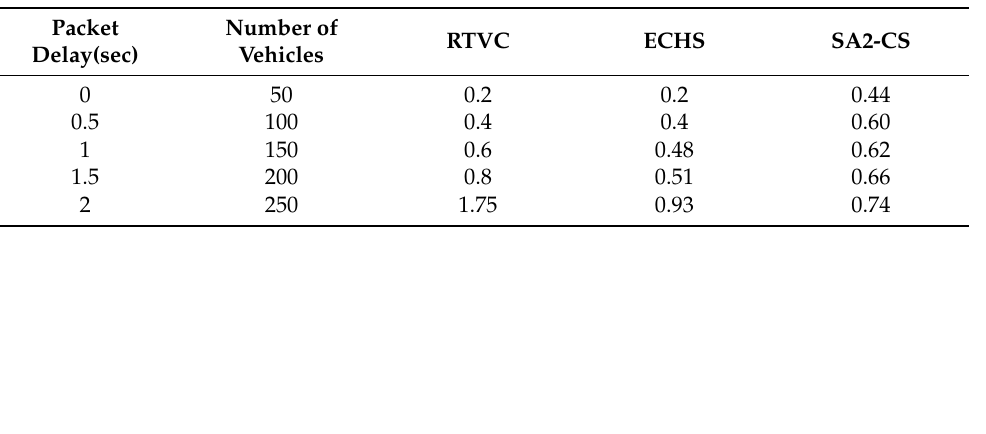
Table 7. Analysis of Average Packet